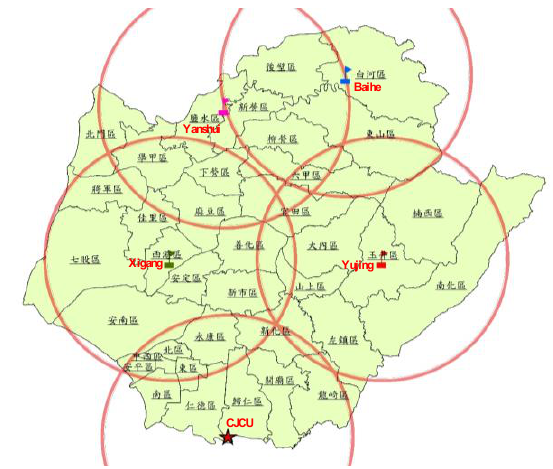
Figure 3. Long range wide area network (LoRa) ground transceiver station (GTS) deployment in Tainan for the first proof of concept (POC).